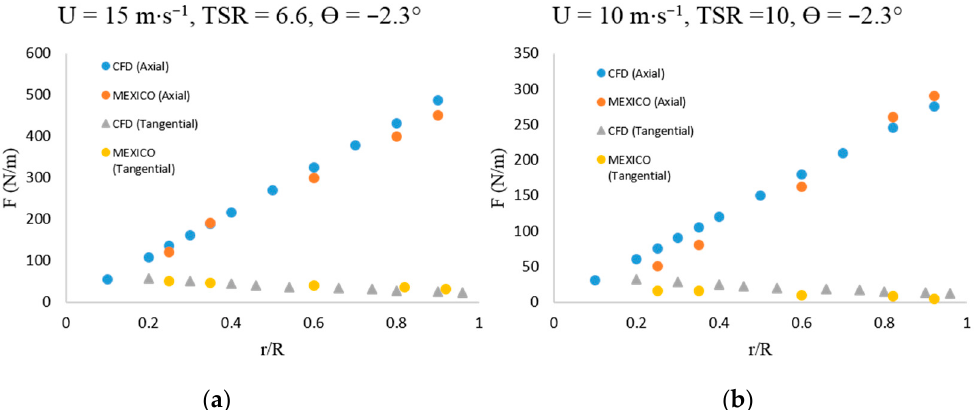
Figure 5. Axial and tangential forces on the rotor, showing comparison between computational and experimental results for ( a ) 15 m ∙ s − 1 and TSR = 6.6; ( b ) 10 m ∙ s − 1 and TSR = 10.